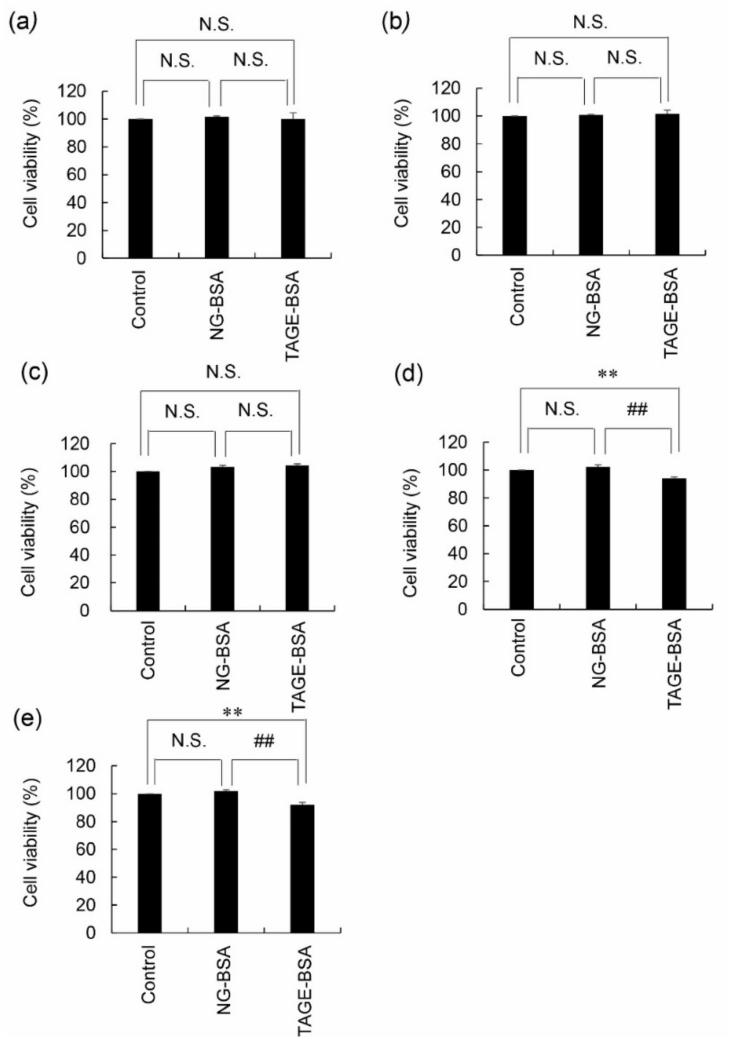
Figure 4. Cytotoxicity of TAGE-BSA against 1.4E7 cells with assessed using the CellTiter-Glo lu- minescent assay. Cells were seeded in five wells and the average was calculated. This assay was performed to evaluate cell viability in three independent experiments. Data are shown as the mean ± S.D. ( n = 3). p -values were based on Tukey’s test. ( a ) Cells were treated with 10 µ g/mL NG-BSA and TAGE-BSA for 24 h. ( b ) Cells were treated with 20 µ g/mL NG-BSA and TAGE-BSA for 24 h. ( c ) Cells were treated with 50 µ g/mL NG-BSA and TAGE-BSA for 24 h. ( d ) Cells were treated with 100 µ g/mL NG-BSA and TAGE-BSA for 24 h. ( e ) Cells were treated with 200 µ g/mL NG-BSA and TAGE-BSA for 24 h. ( d , e ) ** p < 0.01 vs. the control. ## p < 0.01 vs. the NG-BSA treatment. ( a – e )